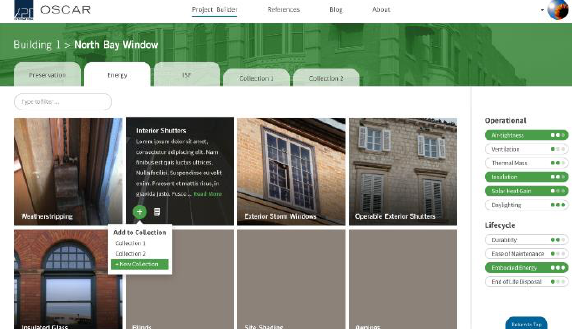
Figure 7. Component Manager high definition